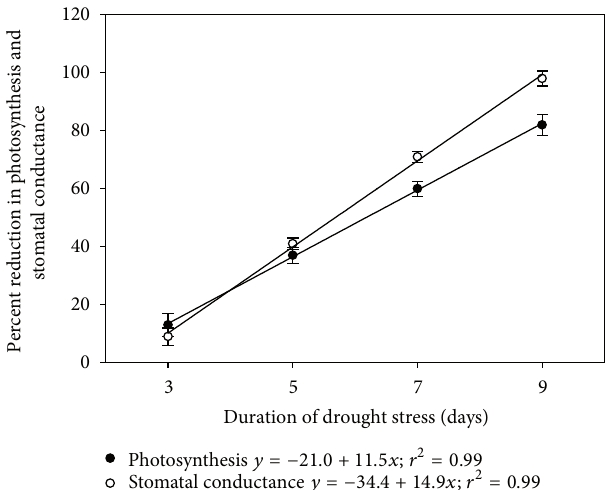
Figure 3: Percent reduction in photosynthesis and stomatal conductance of an acetolactate synthase-sensitive and glyphosate-sensitive (ALSS/GS) accession as affected by duration of drought stress in days. Points are means ±